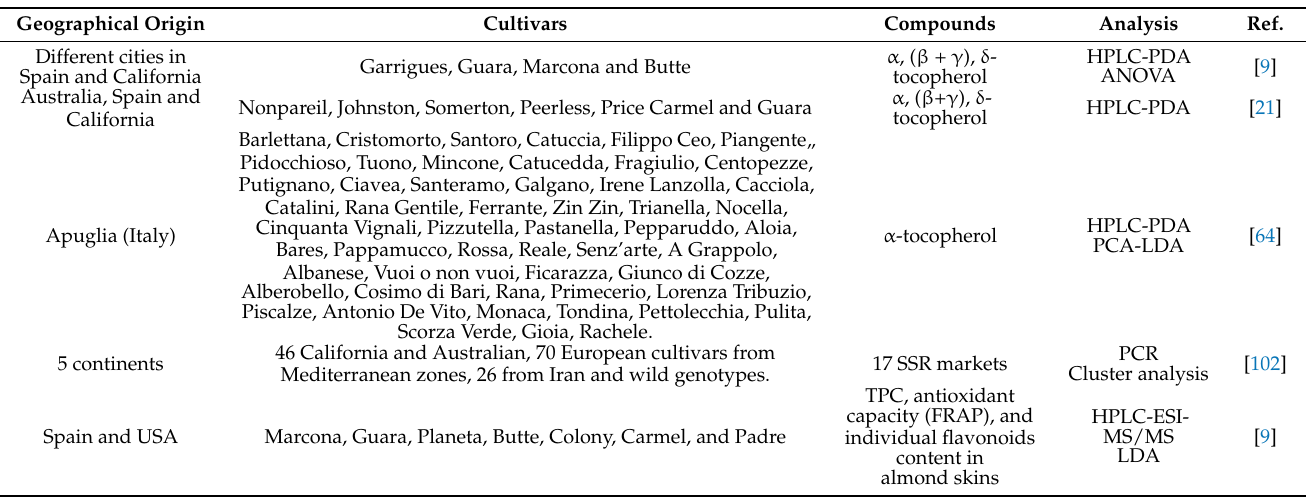
Table 3. Selection of some works in which characterization of Almonds of Different Geographical Origins and Cultivars have been done based on the tocopherol, polyphenol and DNA